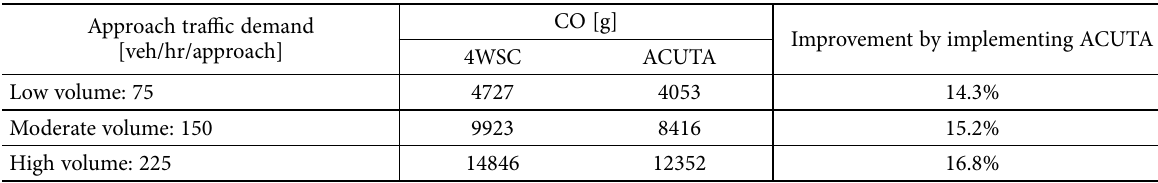
Table 7. Comparison of PM 2.5 emission between single-tile ACUTA and four-way stop control. Approach traffic demand [veh/hr/approach]